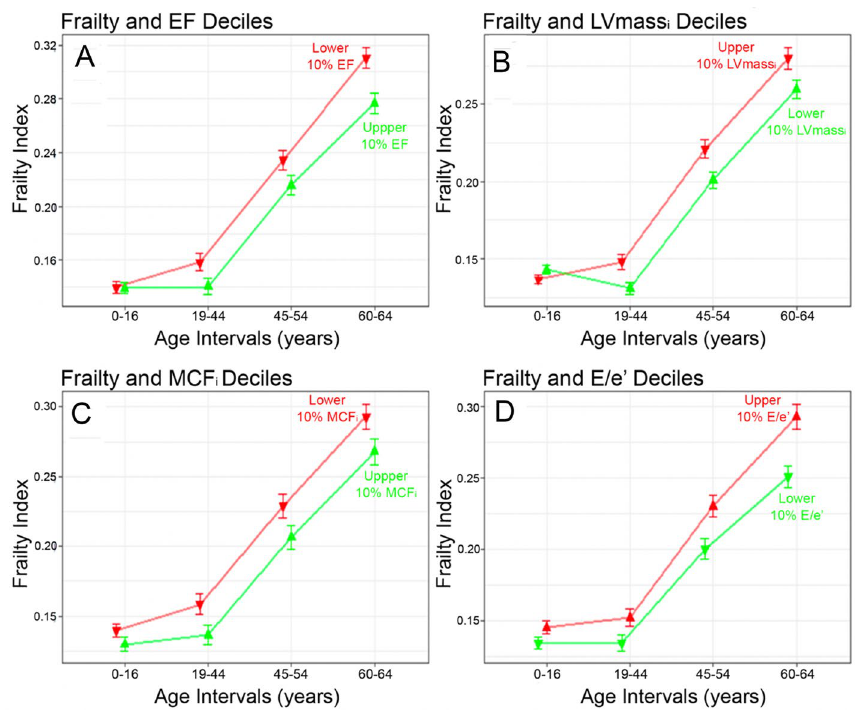
Figure 3. Comparing trajectories of mean life-course FI ( y -axis) at each age interval ( x -axis) in terms of the older age echocardiographic phenotype. FI trajectories leading to favourable phenotypes shown in green and unfavourable trajectories in red as follows: ( A ) highest (green) vs. lowest (red) LV EF deciles; ( B ) highest (red) vs. lowest (green) LVmass i deciles; ( C ) highest (green) vs. lowest (red) MCF i deciles; and ( D ) highest (red) vs. lowest (green) E/e ′ deciles. Vertical bars represent standard error of the means. Wilcoxon signed-rank test p -values (not shown) for median inter-decile Differences were < 0.05 at every time point except for the 0–16 years age interval. EF ejection fraction, LVmass i left ventricular mass index, MCF i myocardial contraction fraction index. Other abbreviations as in Fig.